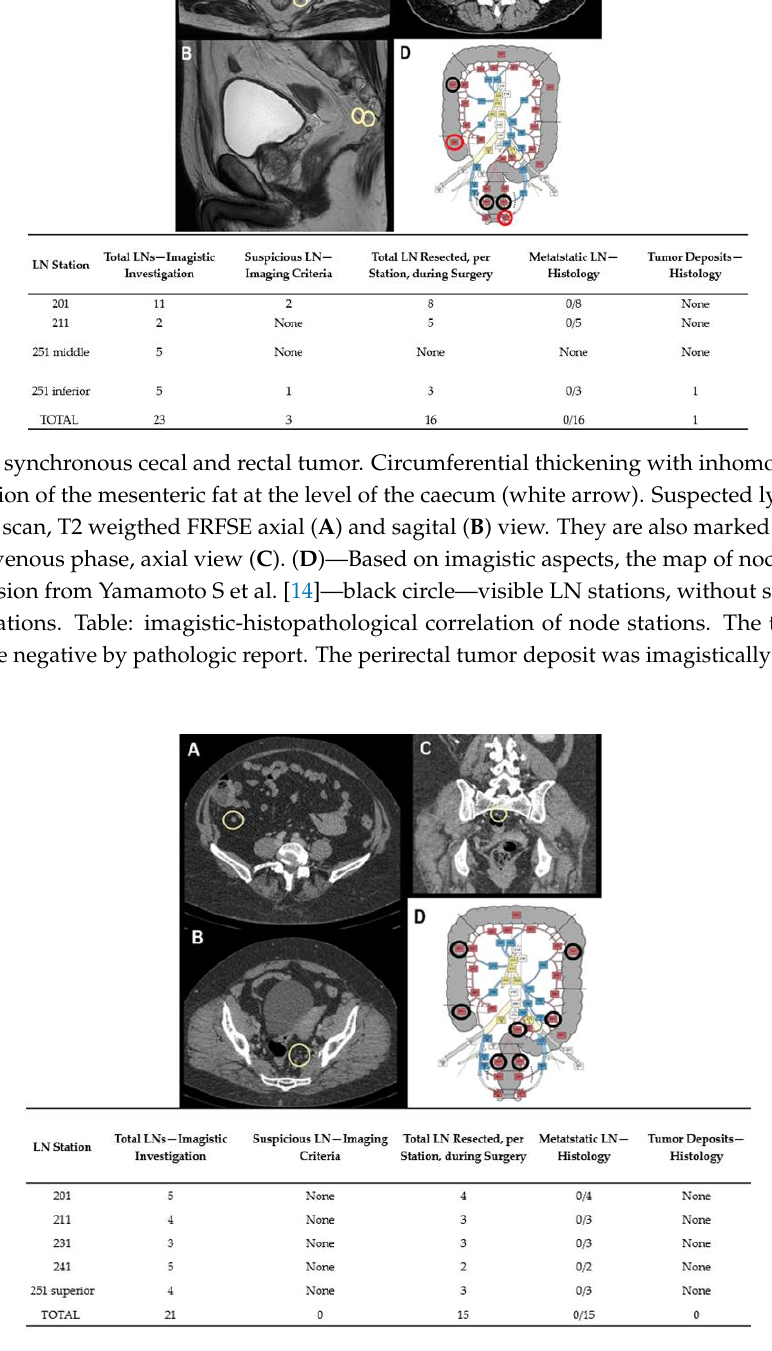
Figure 2. Case No. 2: synchronous cecal and rectal tumor. LNs can be seen on an abdominopelvic contrast-enhanced CT scan, venous phase, axial ( A , B ) and coronal view ( C ). No suspected LNs are detected. ( D )—The map of LN stations—black circles emphasize LN stations, without suspicious features. Table: correlation of LN stations, based on imaging studies and pathological reports. Imaging did not detect any suspicious LNs that was confirmed by pathology